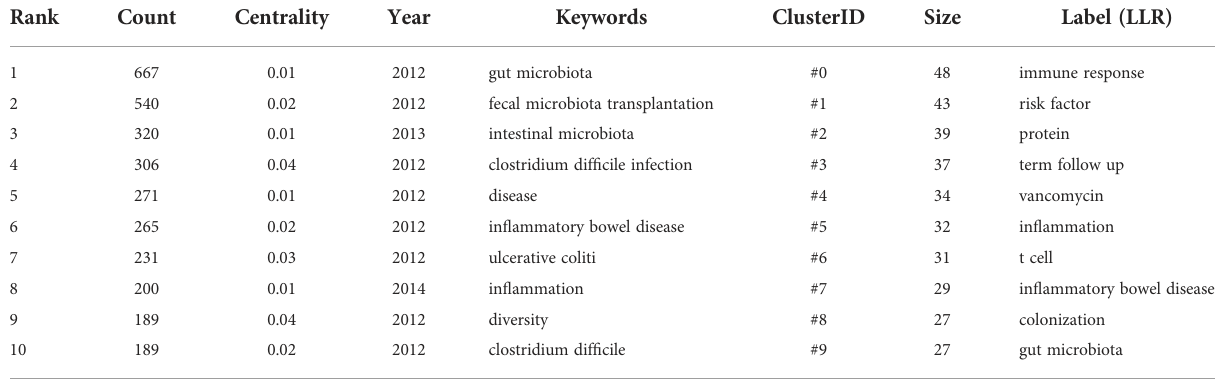
TABLE 4 Top 10 keywords and clusters related to FMT